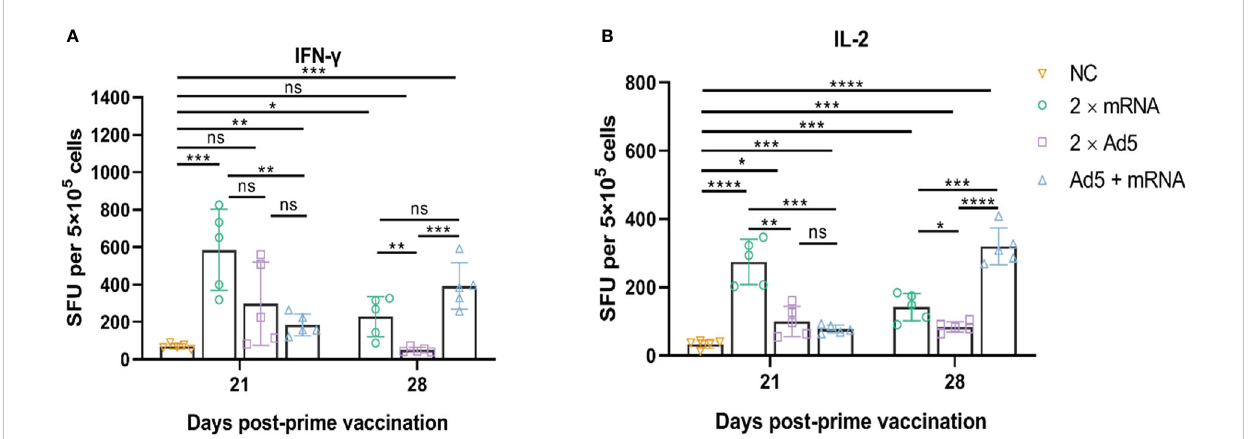
FIGURE 7 CHIKV-speci fi c T-cell responses induced by different immunization regimens. Mice in three groups were immunized with different prime-boost strategies and splenocytes were harvested and analyzed. (A) IFN- g -secreting cells and (B) IL-2-secreting cells were quanti fi ed by ELISpot assay. n = 5 per group; each data point represents the mean number of spots from wells. * p < 0.05; ** p < 0.01; *** p < 0.001; **** p < 0.0001; ns: p > 0.05. NC, negative control; SFU, spot forming units; Ad5, replication-defective human type 5 adenovirus-vectored